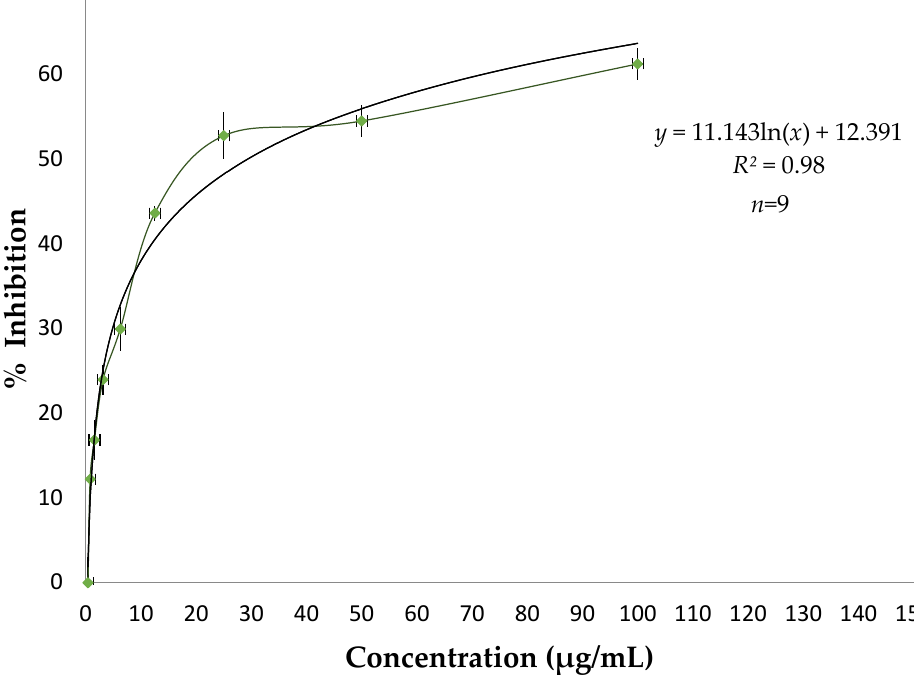
Figure 3. Antioxidant property (IC 50 ) of GLEO along with its logarithmic equation and R 2 value.